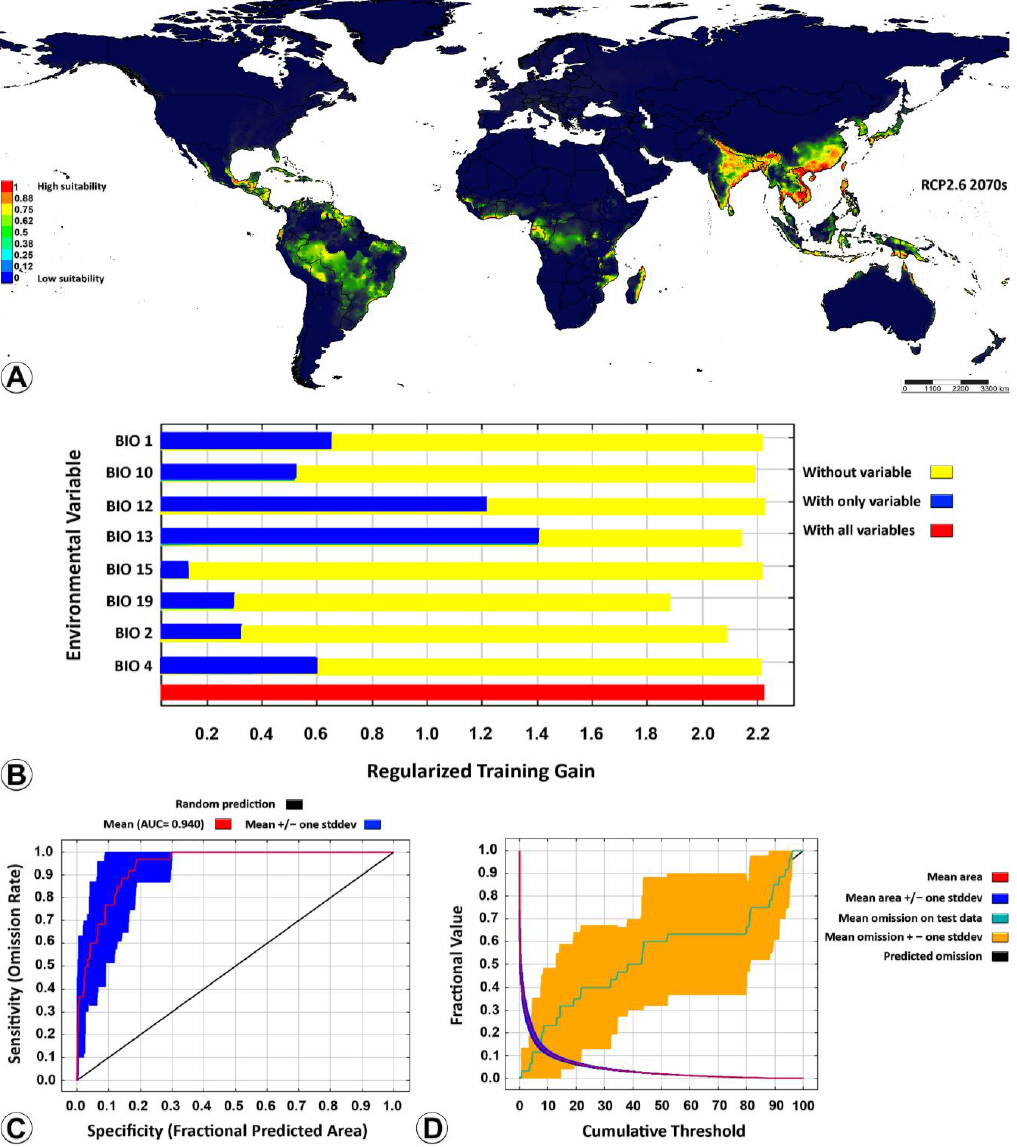
Figure 6. Potential distribution of Microplitis manilae under the RCP2.6 climate change scenario in the 2070s. ( A ) Future suitable distribution under the RCP2.6 scenario in a global context; ( B ) importance of bioclimatic variables to M. manilae by Jackknife test; ( C ) ROC curve of potential distribution prediction; ( D ) curve of omission and predicted area. High-suitability areas has a probability of 1 – 0.75; medium-suitability areas have a probability of 0.75 – 0.5; low-suitability areas have a probability of 0.5 – 0.25; unsuitable areas have a probability of 0.25 – 0. ROC = receiver operating characteristic curve; RCP = representative concentration pathways.